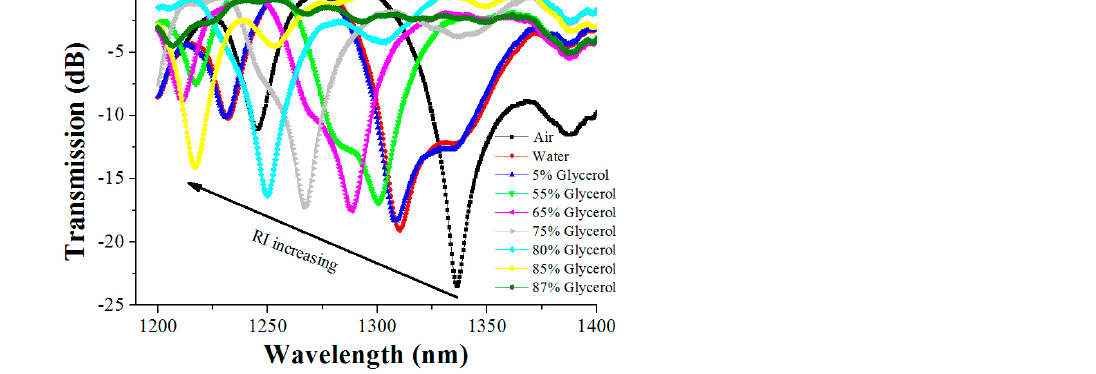
Figure 2. The transmission spectra of the LPFG in different environment media over a wavelength range from 1200 nm to 1400 nm. Table 1. The refractive index (RI) sensitivities of the two resonant peaks in the transmission spectra of the LPFG.